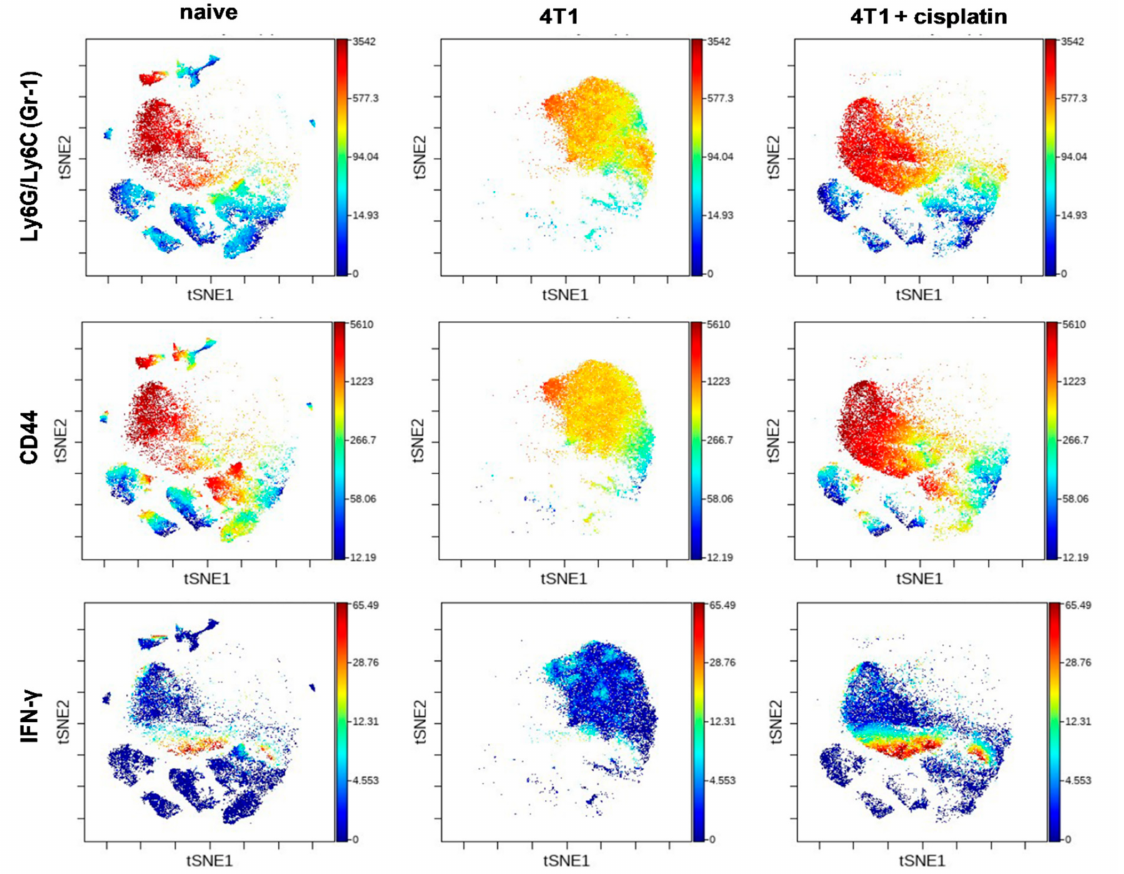
Figure 8. The viSNE plots illustrate the expression intensity of Gr-1, CD44, and IFN- γ markers within the clouds of main subsets defined in Figure 7 in the blood samples of naive, 4T1 tumor bearing, and cisplatin treated 4T1 tumorous mice. The coloration is proportional with the expression intensity (blue = low, red = high). The list of the antibodies can be found in Table 1 in the Section 4.5. Representative viSNE plots are shown from the pooled samples of 6 mice per group. The markers of the panel which were not detected or did not showed di ff erent expression are not shown. Quantitation of the populations with characteristic protein expression was performed by manual gating within the CD45 + living singlets of blood-derived leukocytes. The trajectories on the radar plots delineate the characteristic marker profile of peripheral leukocytes of naive, 4T1 tumor bearing, and cisplatin treated tumorous mice (Figure